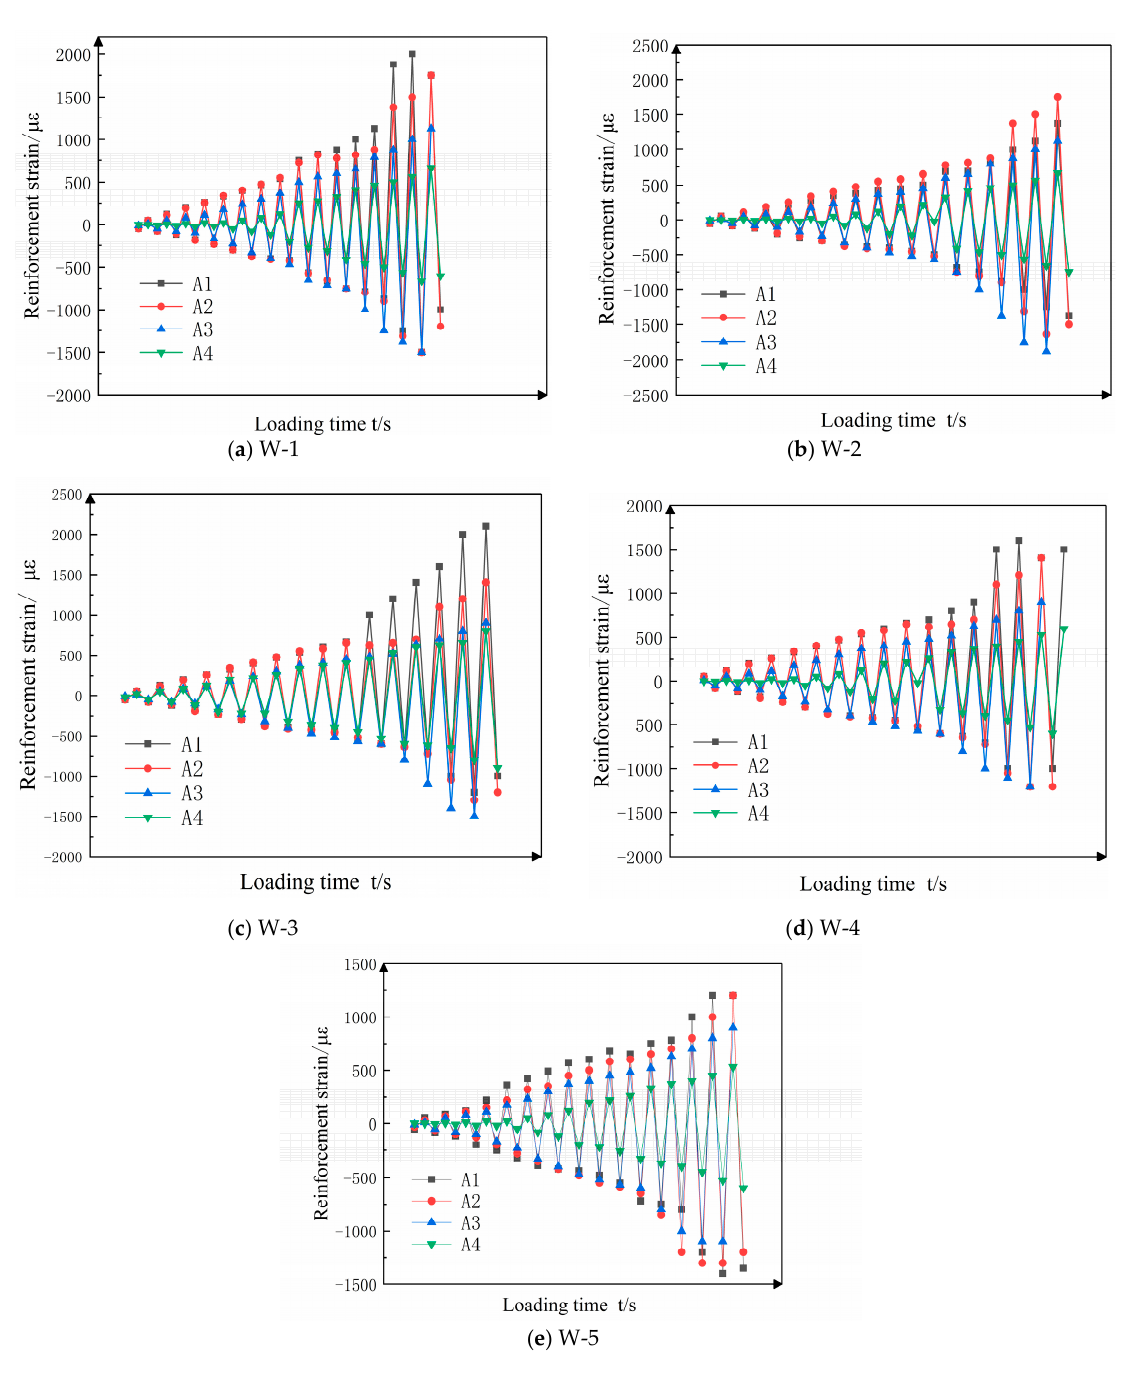
Figure 12. Longitudinal strain diagram.